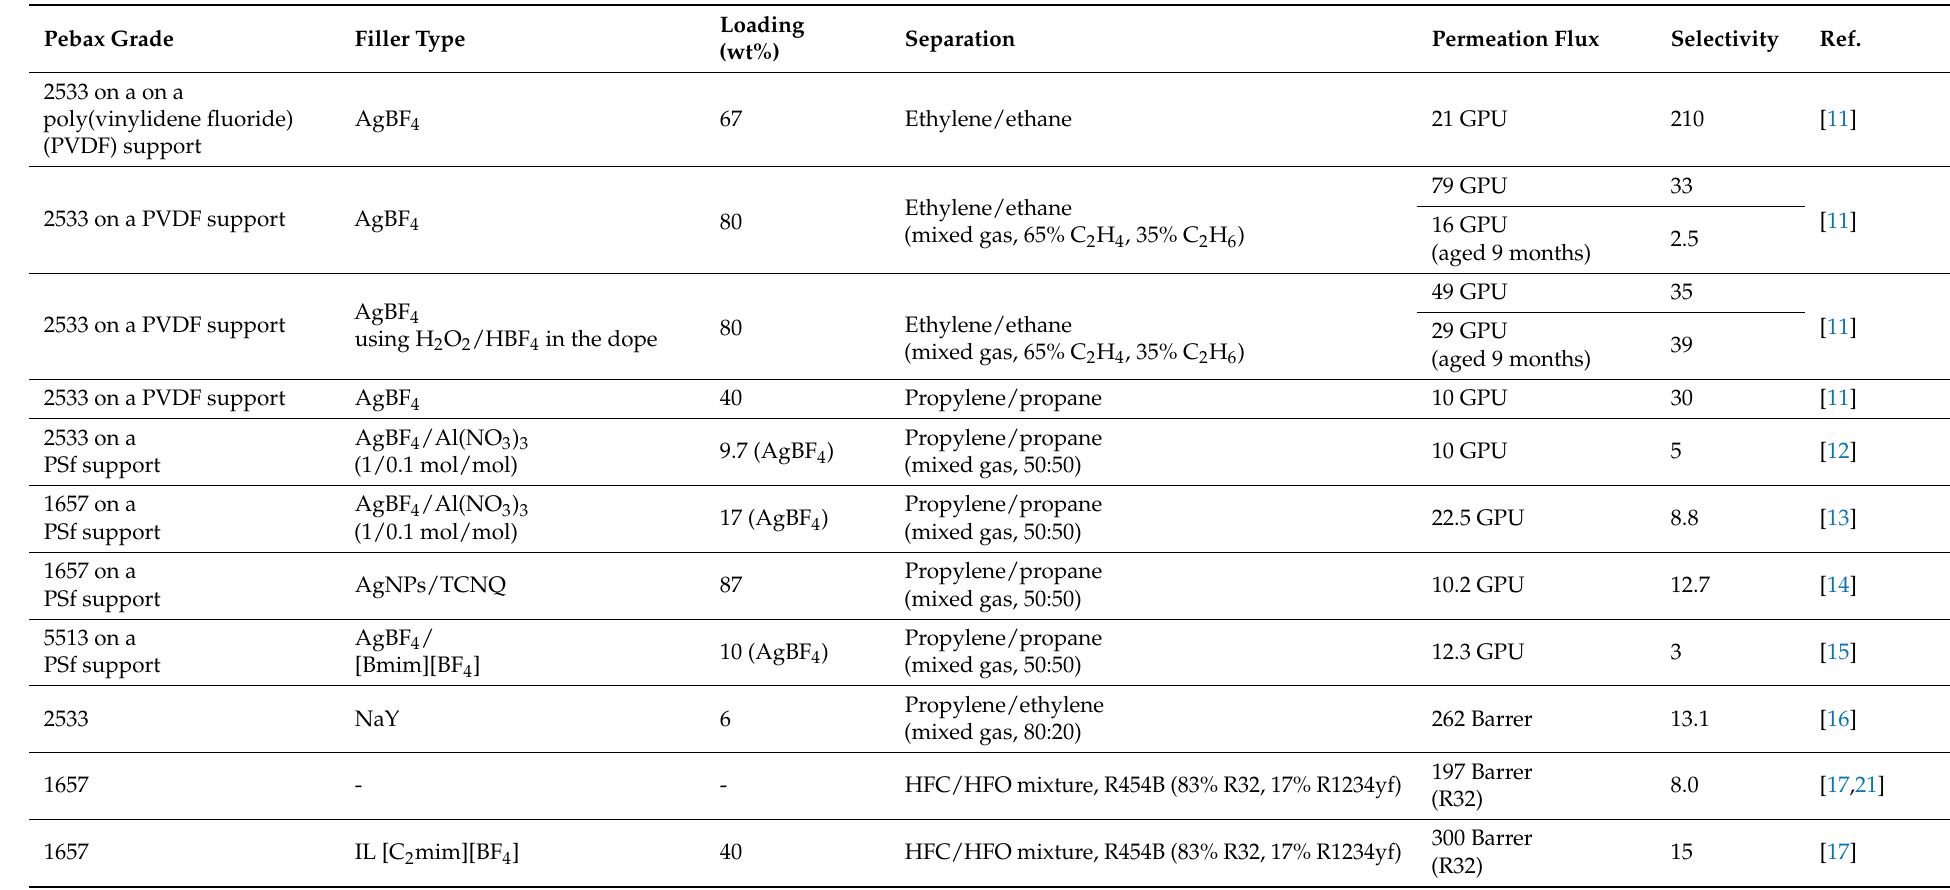
Table 4. Performance of Pebax-based MMMs in the olefin/paraffin